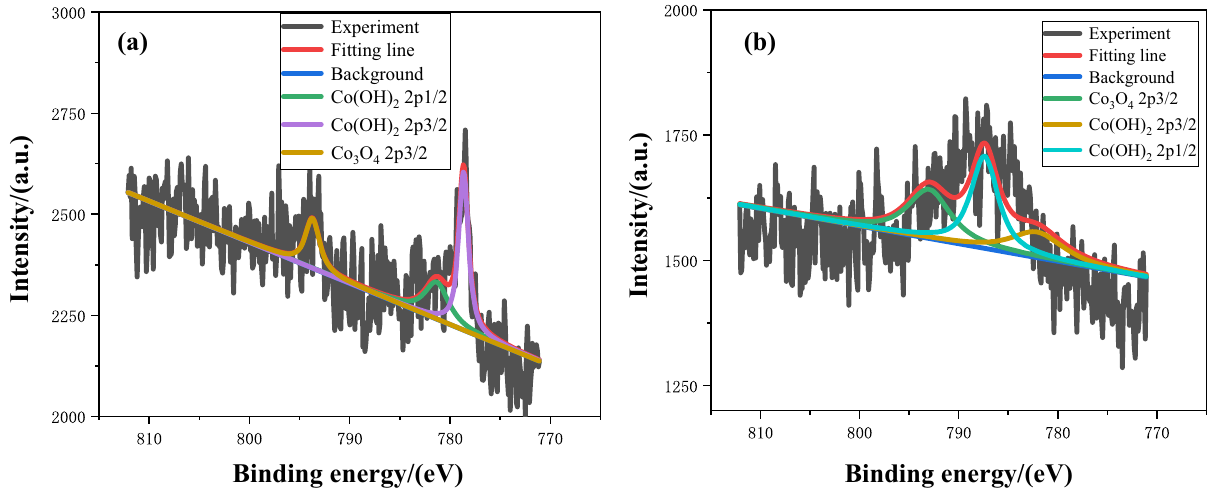
Figure 13: XPS spectra of the surface of Co - based sample after low temperature immersion. ( a ) Co 2p in 3.5 wt% NaCl solution; ( b ) Co 2p in 0.5 mol · L − 1 HCl